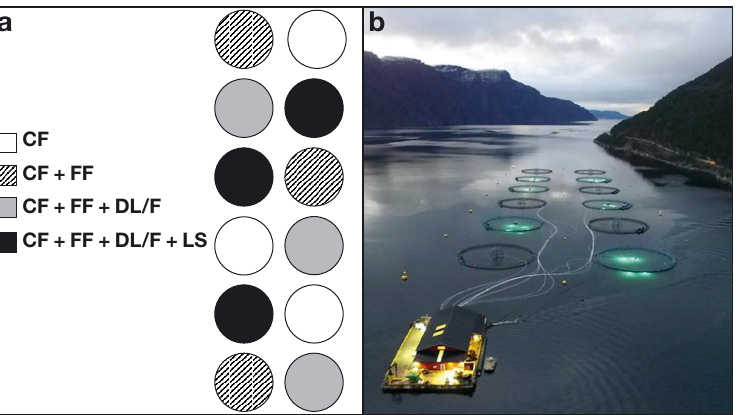
Fig. 1. (a) Diagrammatic representation of the Vindsvik study site and experi- mental design. Each circle represents a 120 m circumference sea cage, with shade representing anti-lice strategy. Strategies were allocated to sea cages in a randomised block design. CF: cleaner fish, FF: functional feed, DL/F: deep light and deep feeding, LS: lice skirts. (b) Aerial view of the study site at dusk with underwater light treatments clearly visible in